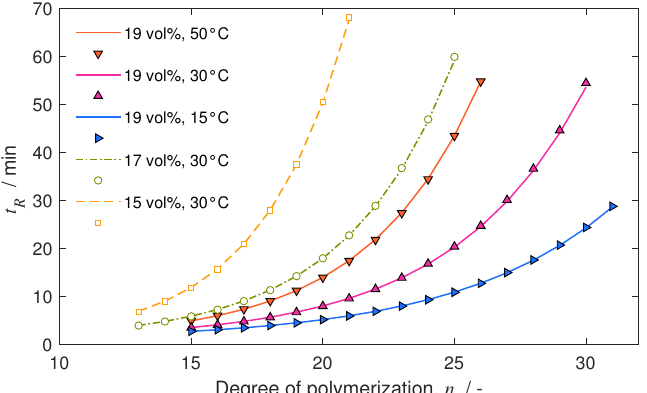
Figure 5. Evaluation of the thermodynamic retention model for the preparative column at different conditions. Comparison of retention times for the chromatograms shown in Figure 2 (symbols) to the predictions by the thermodynamic retention model